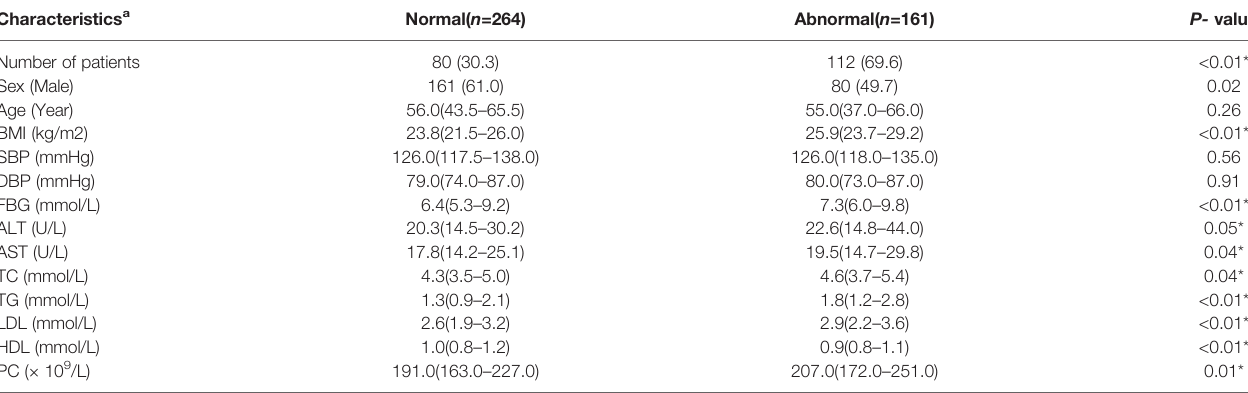
TABLE 4 | Baseline characteristics of subjects strati fi ed according to hsCRP